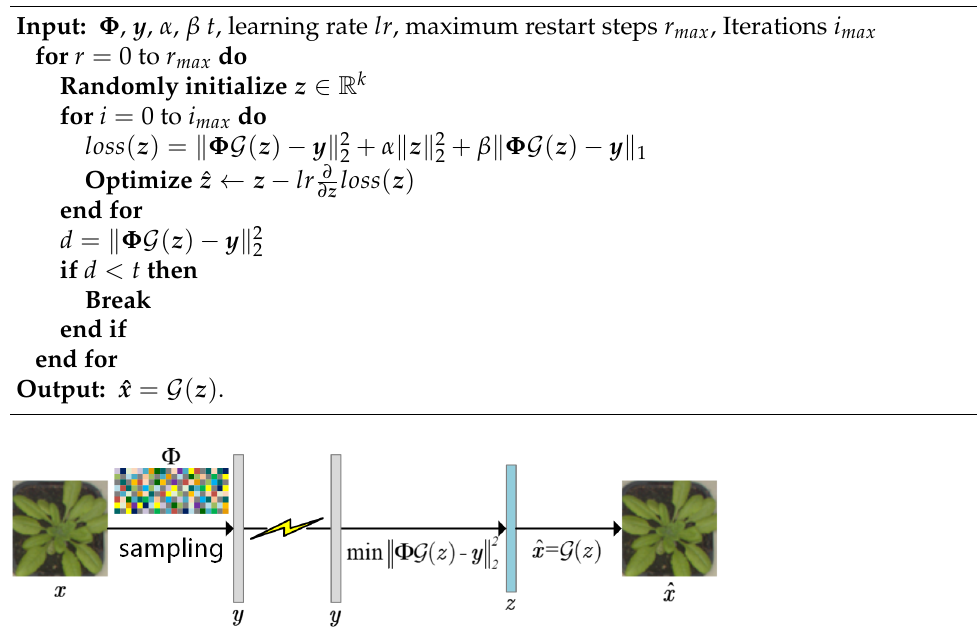
Algorithm 1 Proposed Approach